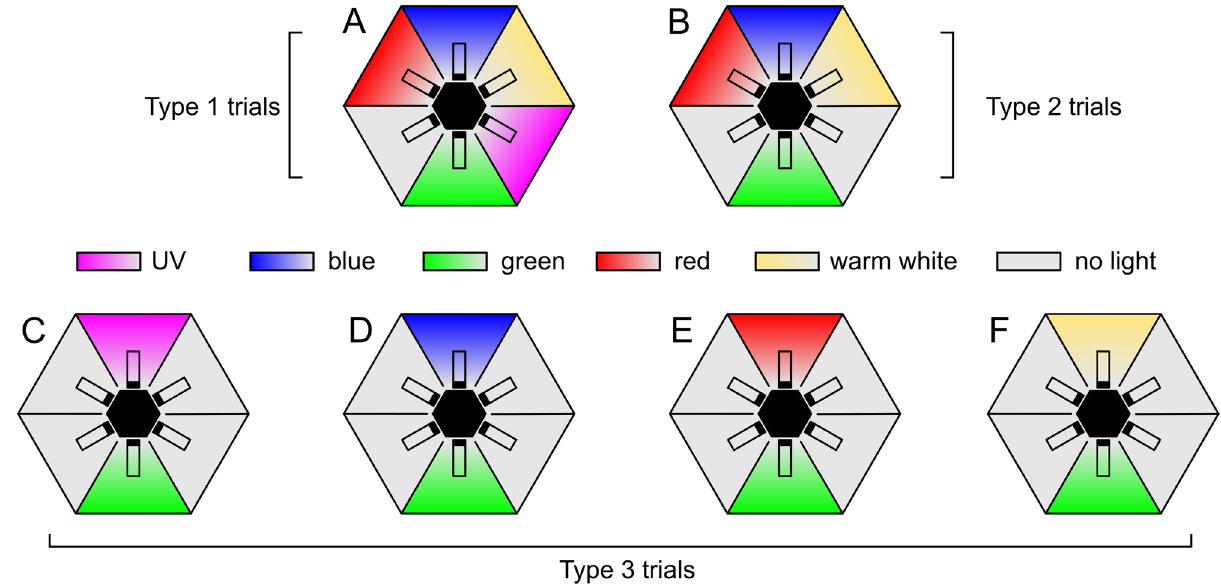
Figure 3. Arrangement of stimuli in the different trial types in behavioural experiment 2. ( A ) Type 1 trials (